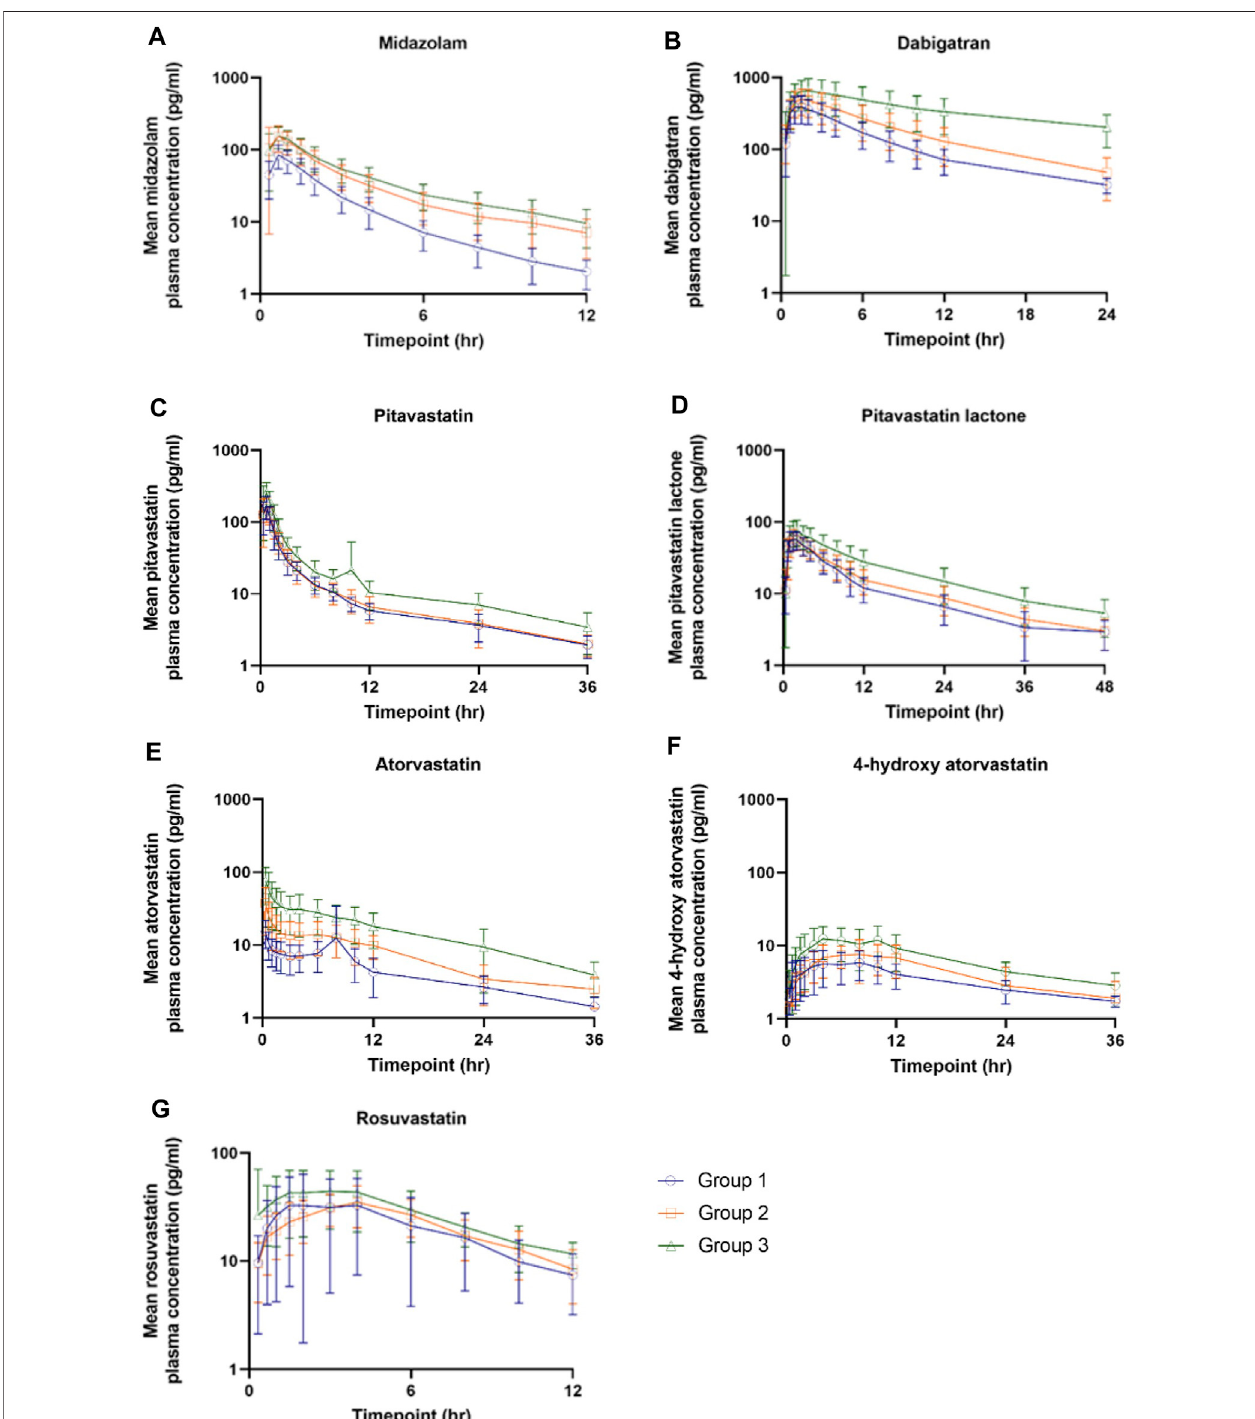
FIGURE 2 | The plasma concentration-time curves of microdose cocktail probe substrates in three groups of participants (A) Midazolam (B) Dabigatran (C) Pitavastatin (D) Pitavastatin lactone (E) Atorvastatin (F) 4-hydroxy Atorvastatin, and (G) Rosuvastatin. Group 1: healthy young participants; Group 2: healthy elderly participants; Group 3: elderly patients with chronic kidney disease.